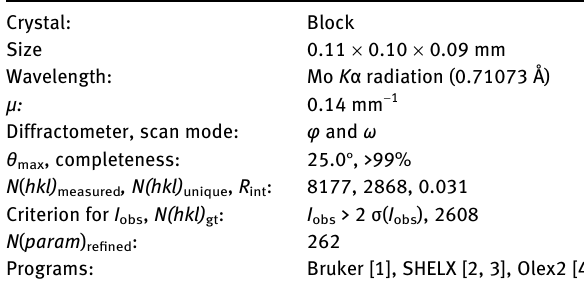
Table  : Data collection and